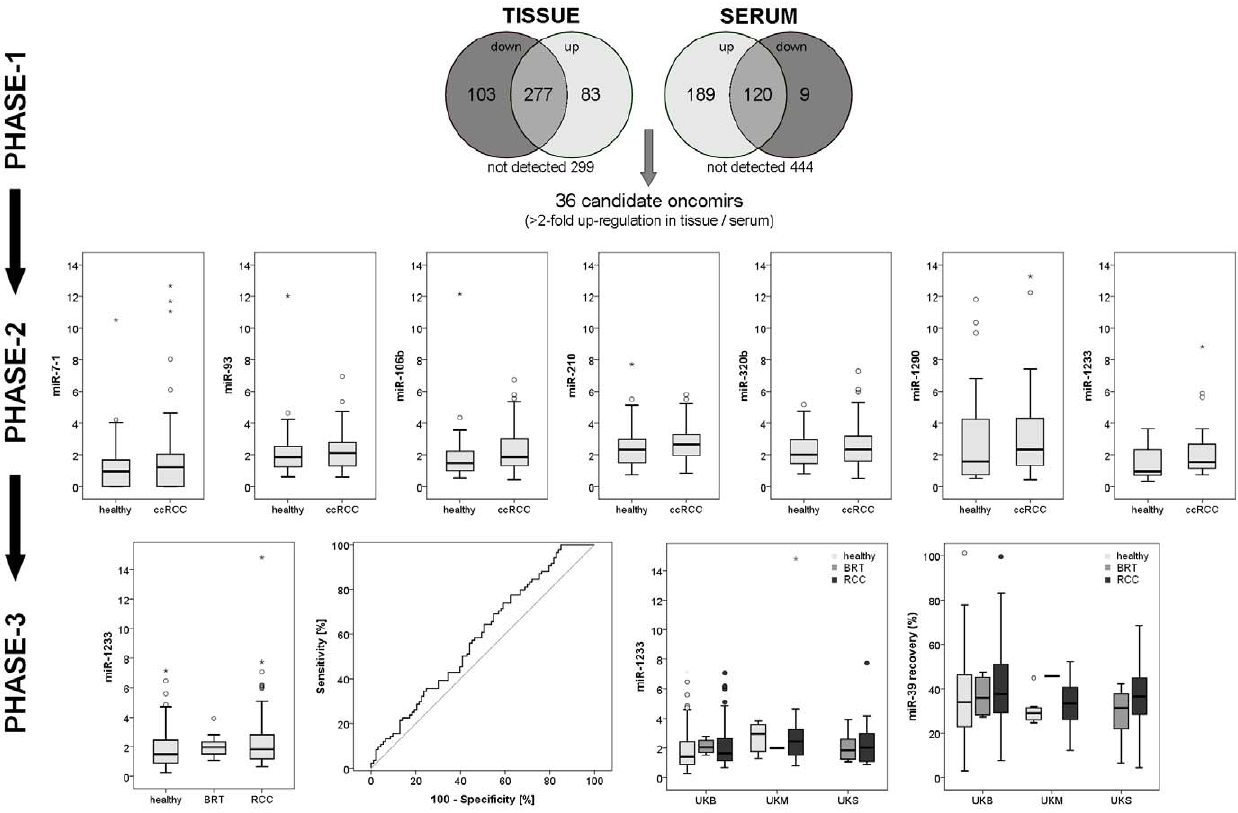
Figure 2. Serum microRNA levels in patients with renal cell carcinoma, benign renal tumors and healthy controls. MicroRNAs were profiled in serum and tissue of patients with clear cell renal cell carcinoma (ccRCC) and healthy controls (each n=6) using the TaqMan Low Density Array; 36 microRNAs were upregulated in RCC tissue and serum of RCC patients (Phase-1). Seven microRNAs were chosen for verification using real- time PCR in a cohort of 33 ccRCC and 30 healthy individuals (Phase-2). In Phase-3, the finding of increased serum miR-1233 levels in RCC patients was confirmed in a multicentre cohort of 84 RCC, 93 healthy and 13 benign renal tumors (BRT). MicroRNA recovery (as determined using quantification of the synthetic miR-39) was similar in the study centers (UKB, UKM, UKS); the level of miR-1233 were somewhat higher in patients from UKM.